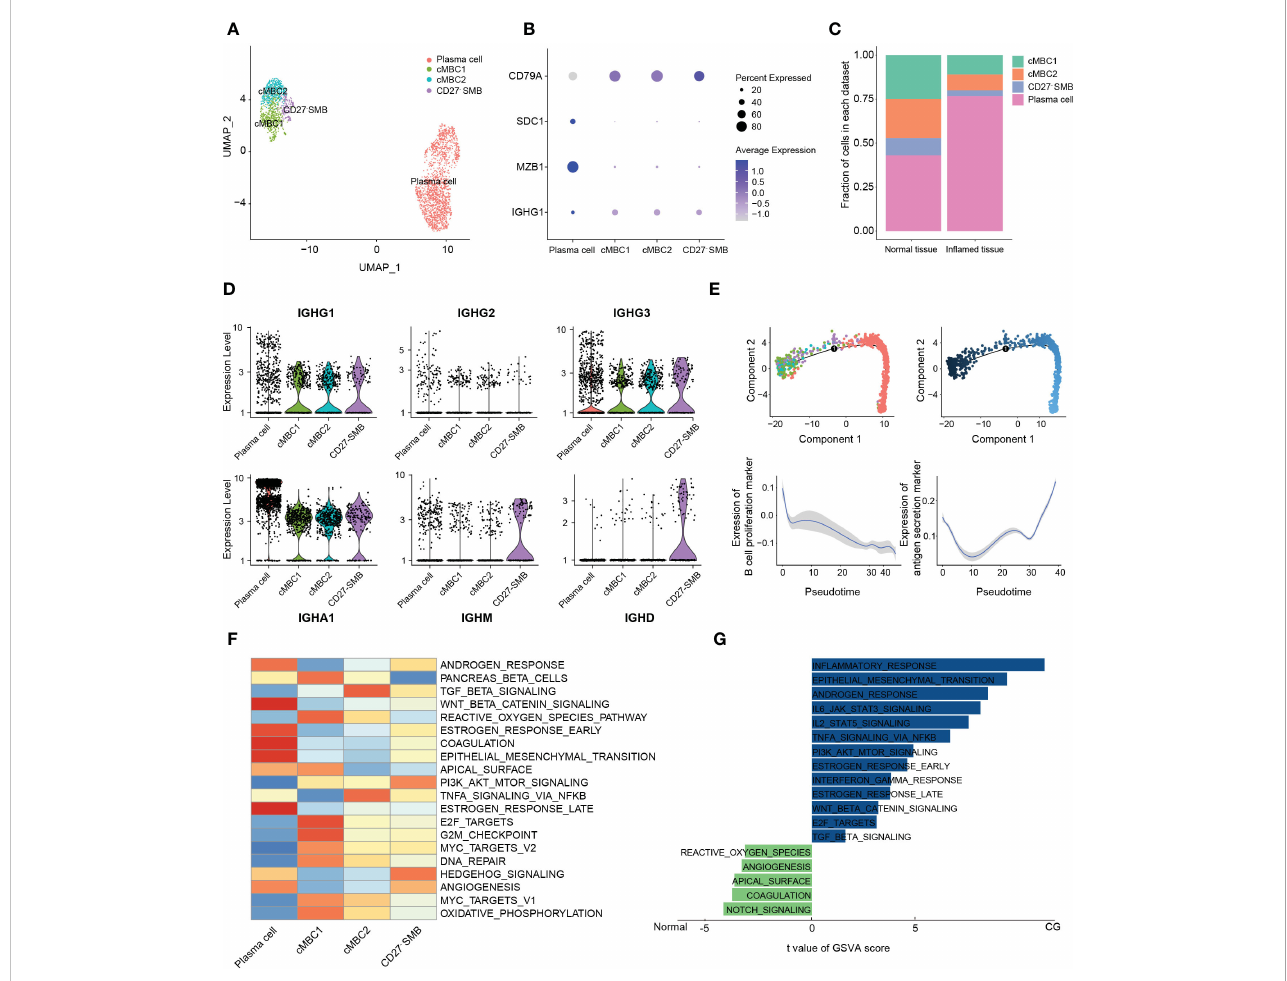
FIGURE 4 Classi fi cation and analysis of B cells in cystitis glandularis. (A) U-MAP showing the distribution of B cell subsets in different colors. (B) Dot plot used to represent the canonical genes of different B cell subsets. (C) The proportion of each B cell subset in CG and normal tissues. The left panel indicates normal tissue and the right panel indicates in fl amed tissue. (D) Violin plot showing the expression levels of immunoglobulins in different B cell subsets. (E) Monocle2 showing the (top) pseudotime differentiation trajectory of B cells and (bottom) the change of proliferation and antigen secretion ability of B cells. (F) Heat map showing pathway activity of different B cell subsets using GSVA analysis. (G) GSVA calculation of the pathway activity of plasma cells between CG and normal tissues. The horizontal axis shows the pathway score, the right side shows the CG-enriched pathway, and the left side shows the normal tissue enriched pathway. This fi gure displays partial information only. See supplementary table 7 for further